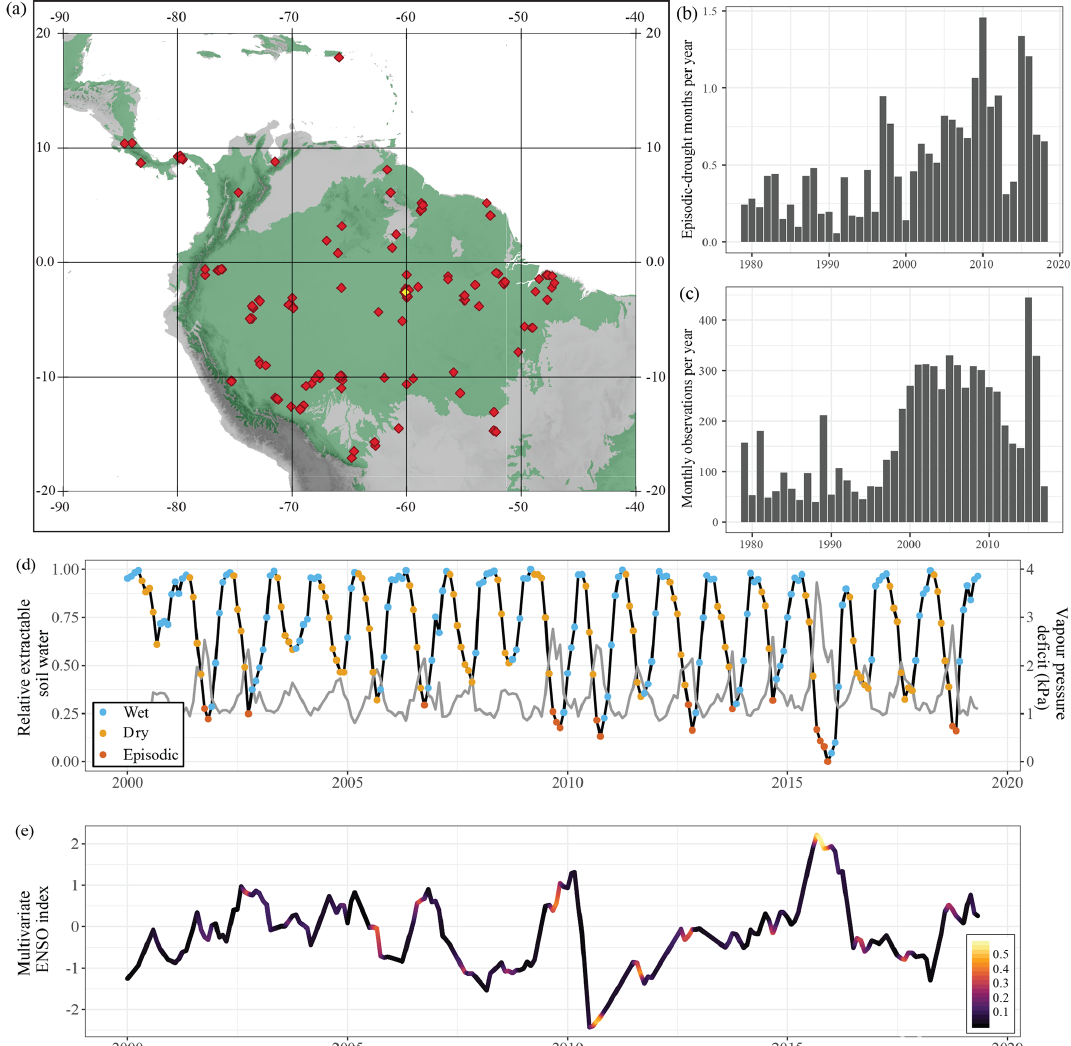
Figure 1. Summary of the database. Site locations (a) , average number of episodic-drought months per year (b) and number of monthly observations in the database per year (c) . The map shows the locations of the 229 Neotropical forest sites from which data were used in this meta-analysis. In green is the distribution of tropical and subtropical moist broadleaf forest from the “Terrestrial Ecoregions of the World” map (Olson et al., 2001). The average number of episodic-drought months per year (b) was calculated as the average number of months classified as episodic drought per year recorded at all sites, independent of whether we have field data for these months. Below, a monthly time series of relative extractable water (light grey) and vapour pressure deficit (dark grey) for the K34 site in the central Amazon (d) is indicated in yellow on the map (a) . The coloured dots indicate whether that specific month was classified as a wet season, dry season or episodic-drought month. (e) A time series of the multivariate ENSO index with positive values indicating El Niño (dry) conditions and negative values La Niña (wet) conditions. The colouring of the ENSO index represents the number of episodic-drought months recorded per month across the sites in the database, ranging from 0 (no droughts recorded) to 0.58 (episodic drought in 58% of the